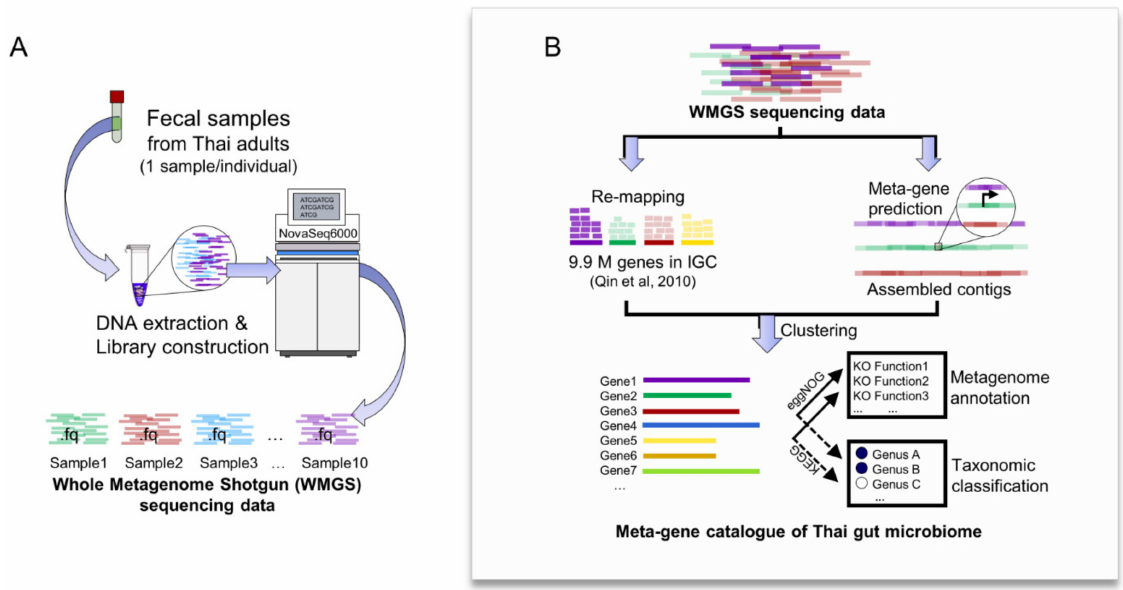
Figure 2. Schematic overview of whole metagenome shotgun (WMGS) sequencing assessment and meta-gene catalogue of Thai gut microbiome construction. ( A ) Assessment of WMGS sequencing data obtained from the gut microbiome of Thai adults and ( B ) An integrated pipeline for constructing the meta-gene catalogue of Thai gut